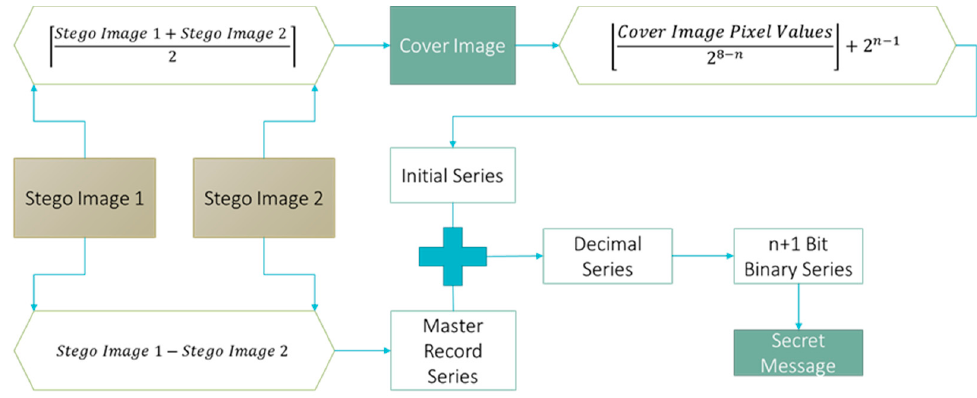
Figure 5. The flow chart of the data extraction process.